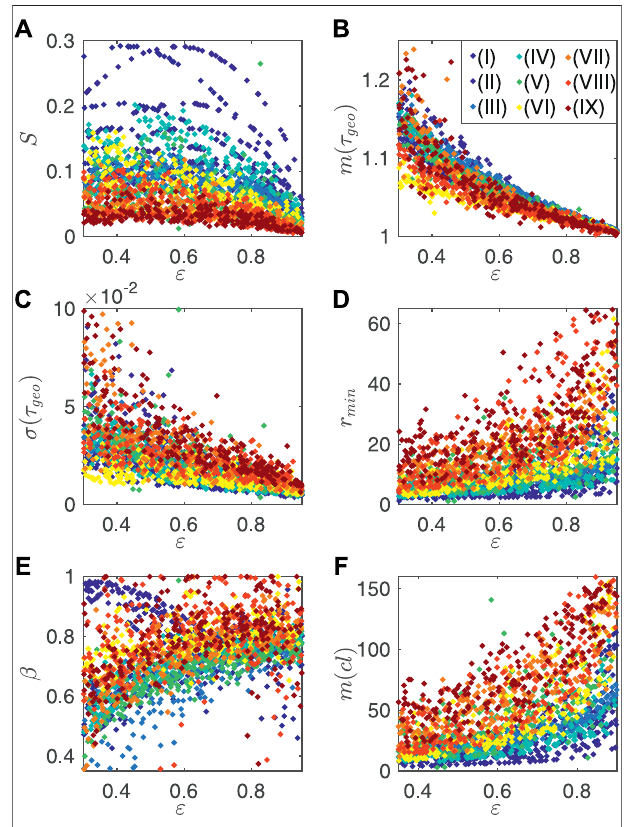
FIGURE 2 | Speci fi c surface area (in (voxelunit) − 1 ) (A) , mean geodesic tortuosity (B) , standard deviation of geodesic tortuosity (C) , characteristic bottleneck radius r min (in voxelunit) (D) , constrictivity (E) and mean chord length (in voxelunit) (F) as a function of porosity, where 250 structures have been randomly selected for each of the nine different microstructure models, depicted by nine distinct colors. Note that the roman numbers in the legend correspond to the numbering of the nine stochastic model types mentioned at the beginning of Section 4 .